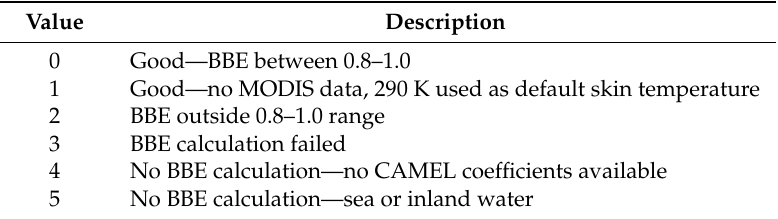
Table 1. CAMEL broadband emissivity quality flag